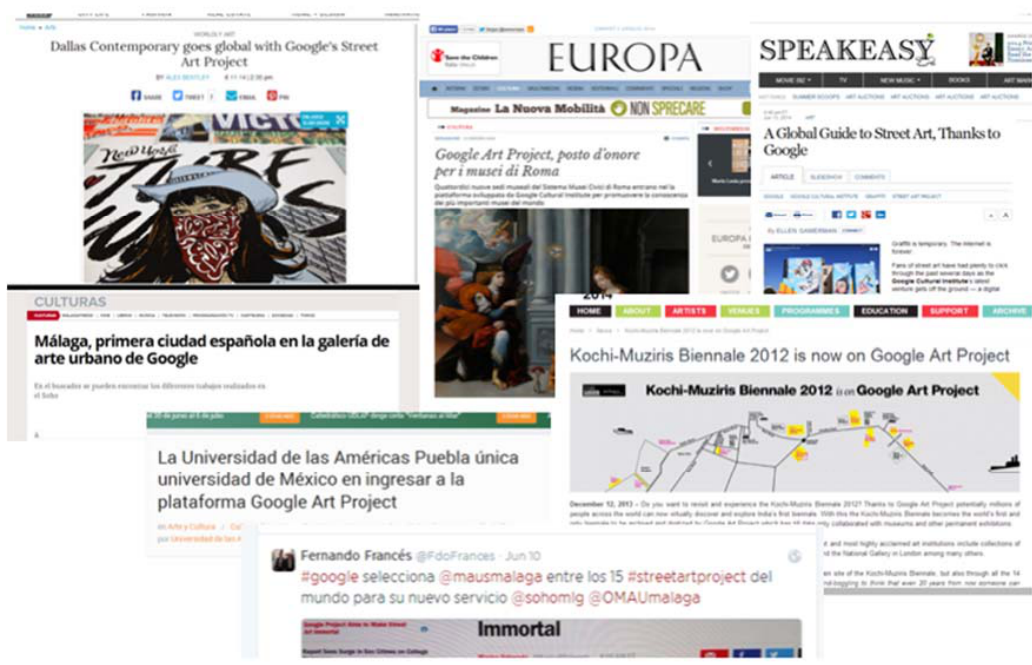
Figure 1. Clippings gathered from the international press about the incorporation of new museum collections in the Google Art Project.